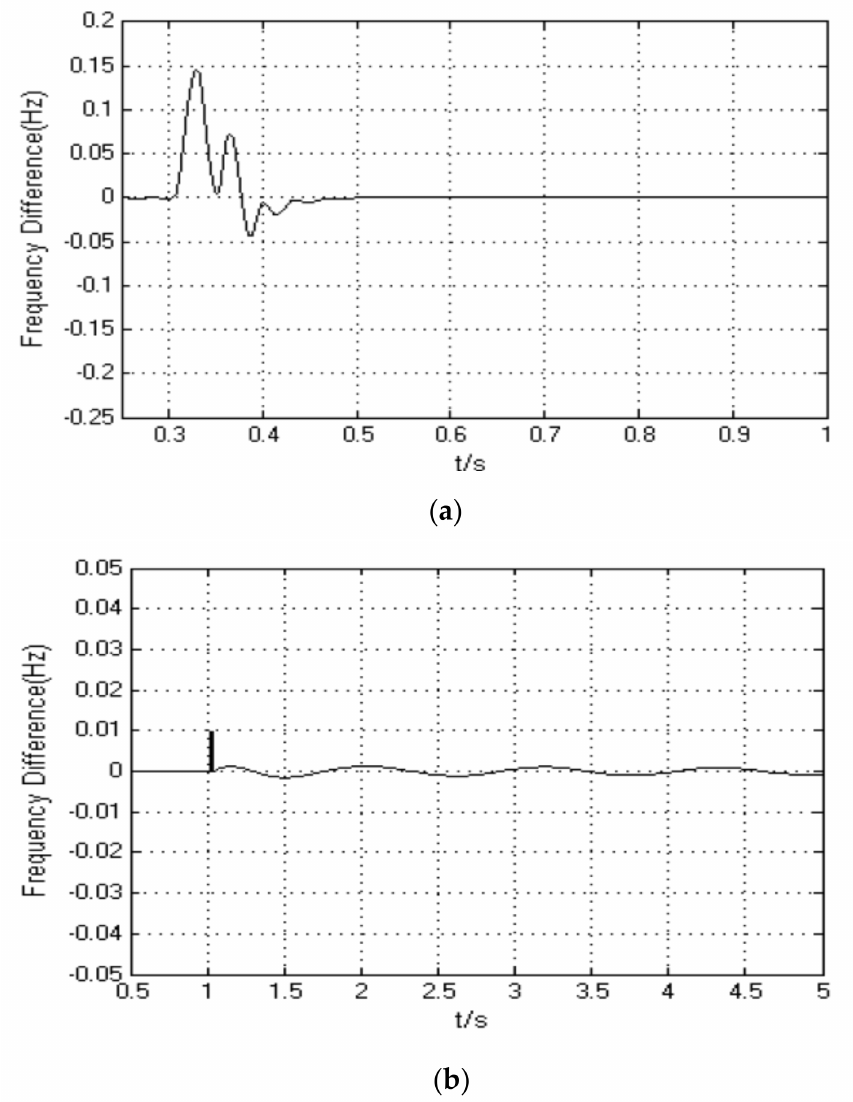
Figure 9. Frequency difference of two PMUs while a generation trip occurs